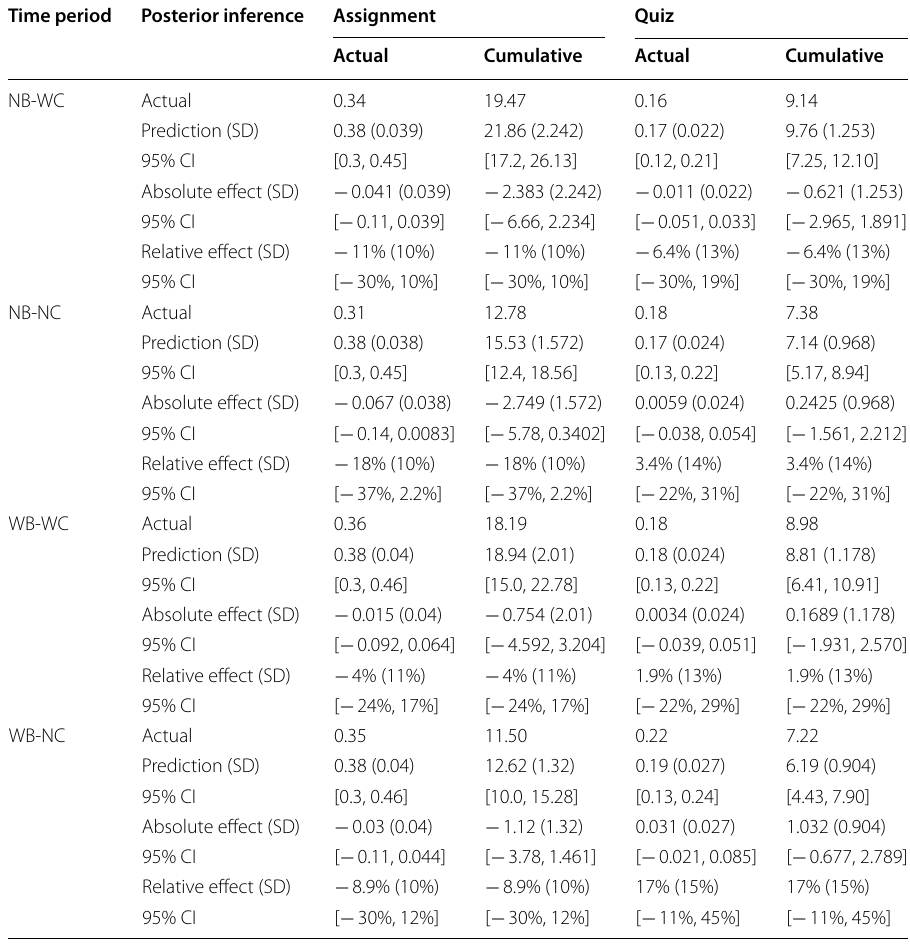
Table 5 CausalImpact